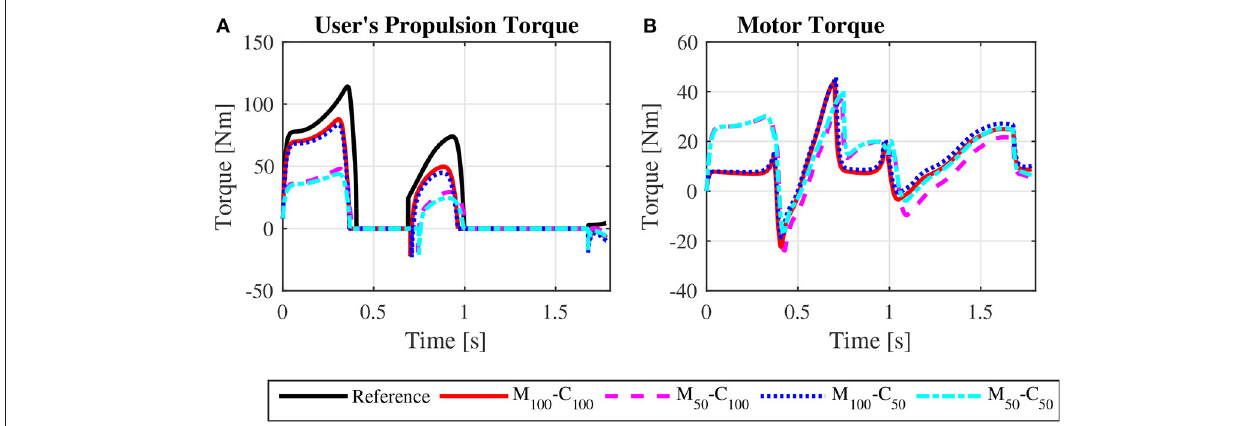
FIGURE 11 | Bilateral propulsion torque applied by the user (A) and bilateral torque applied by the motors on the rear wheels of the wheelchair (B) for startup locomotion on a 3 ◦ ramp at an average speed of 0.9 m/s for the reference unassisted condition (Reference), and for the assisted locomotion with 100% of reference